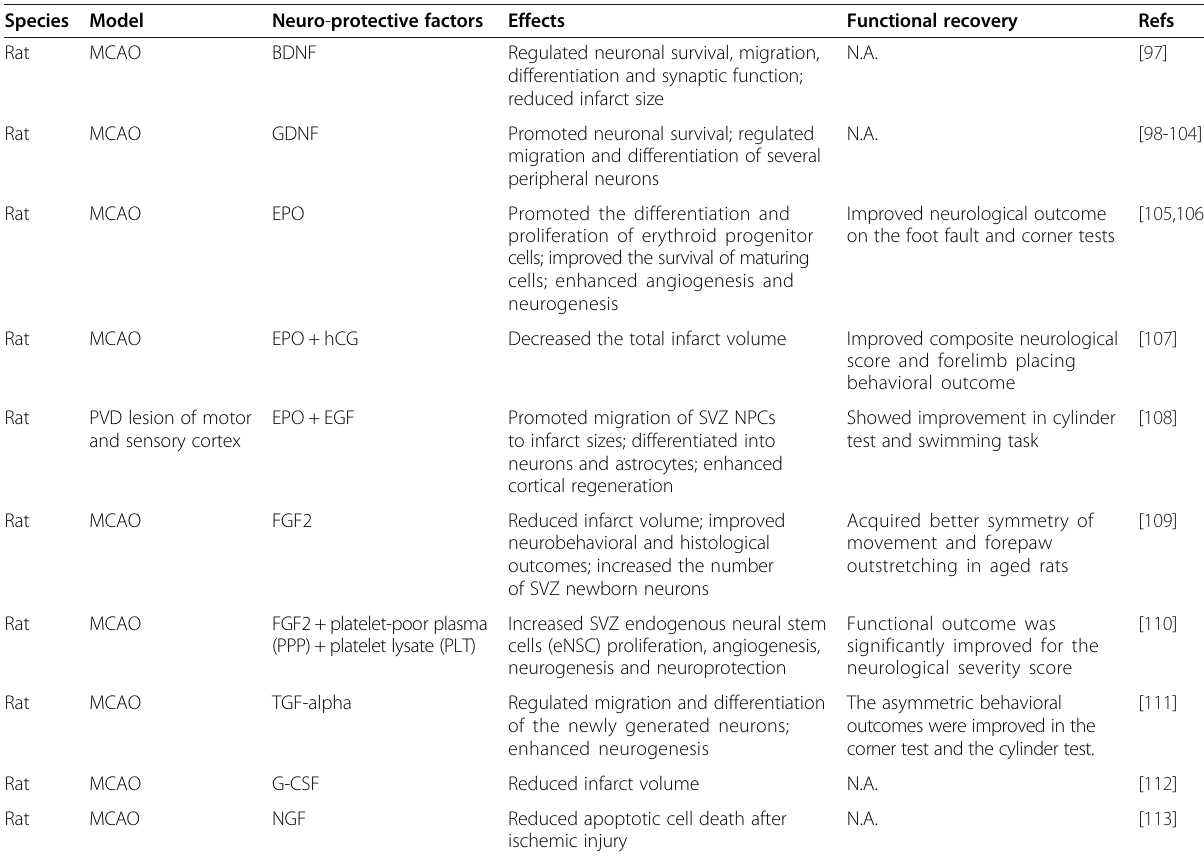
Table 3 Neuro-protective factors used in the treatment of stroke Species